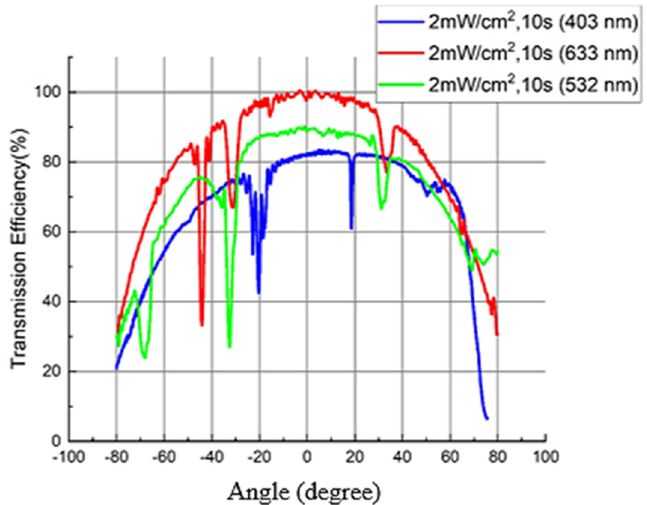
Figure 11. An example of a recording with particularly strong spurious gratings scanned at three wavelengths: 405 nm, 532 nm and 633 nm.